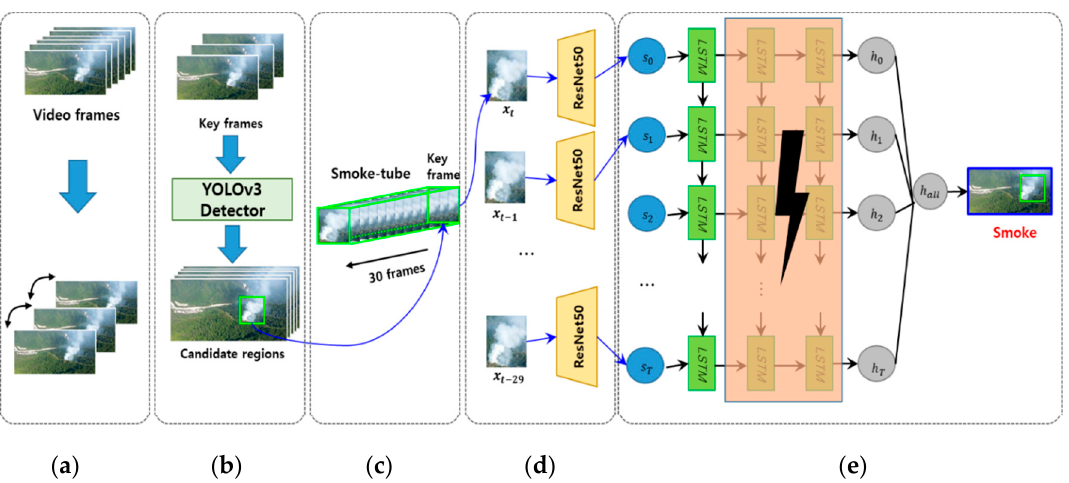
Figure 2. Overall procedure for detecting wildfire smoke: ( a ) Keyframe extraction, ( b ) smoke candidates detection, ( c ) smoke-tube configuration, ( d ) spatial feature extraction, and ( e ) verified wildfire smoke based on shallow student long short-term memory (LSTM); in this step smoke is detected as a student LSTM composed of only one layer obtained in the proposed teacher–student learning framework. The pink part in the figure shows the removed LSTM layers.